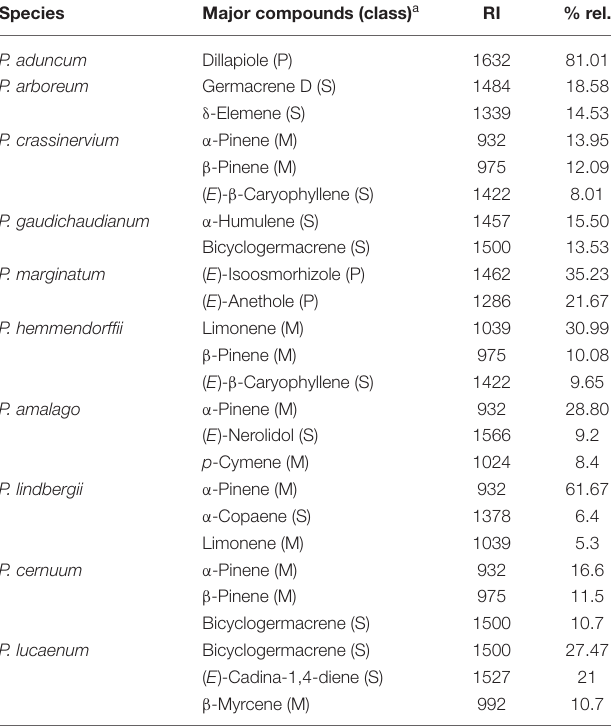
TABLE 5 | Major constituents of the EOs of Piper